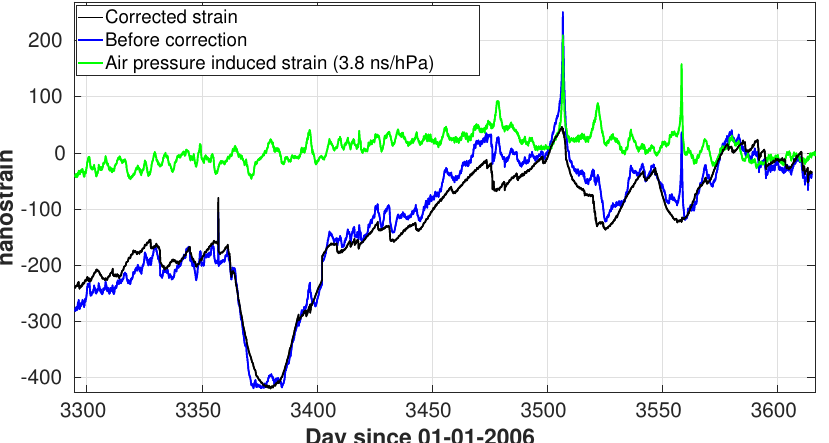
Figure 7. Example of dilatation (detrended, detided and calibrated) recorded by SSTB before and after processing of air pressure-induced strain. Expansion is positive. Note that atmospheric pressure signal is also